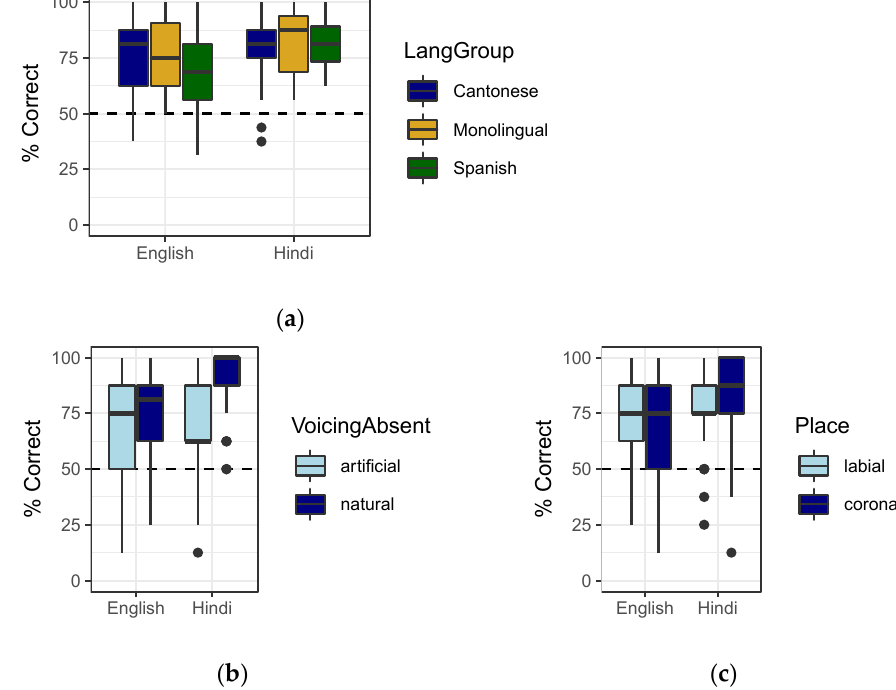
Figure 5. Discrimination accuracy for pairs of stimuli differing in prevoicing, broken down by ( a ) Language Groups, ( b ) artificial vs. natural VoicingAbsent conditions, and ( c ) Places of Articulation. Boxplots show distributions of by ‐ participant means. Table 6. Statistical results for the discrimination task. Effects in bold are significant (p < 0.05).